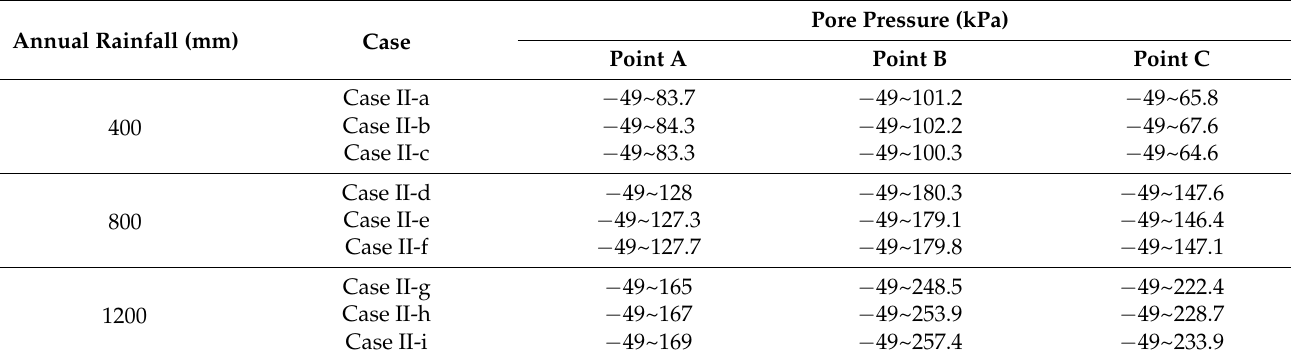
Table 2. Pore pressure variation range at each point in 0–20 years (kPa).